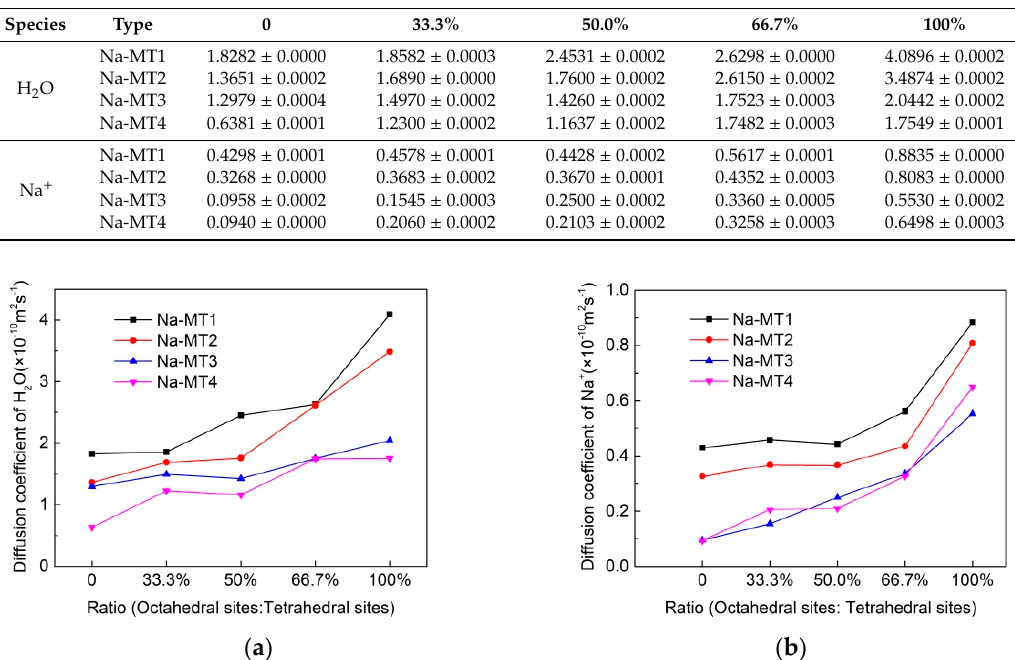
Figure 6. The self-diffusion coefficient of H 2 O and Na + within the interlayer of Na-MT with different crystal chemistry properties, ( a ) H 2 O, ( b ) Na + .